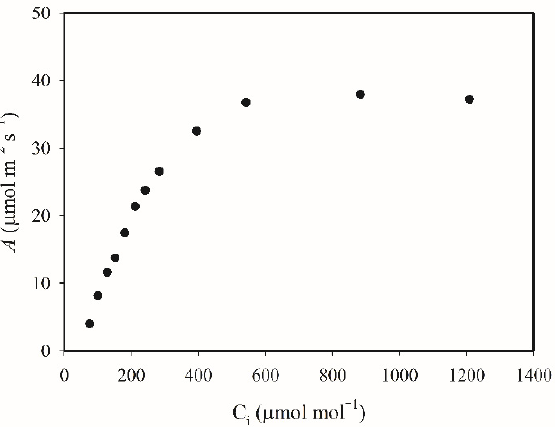
Figure 1. The A /C i curve of rice leaf. A , leaf net photosynthetic rate; C i , intercellular CO 2 concentration. Under current ambient atmospheric conditions (400 µ mol (CO 2 ) mol − 1 (air)), the A